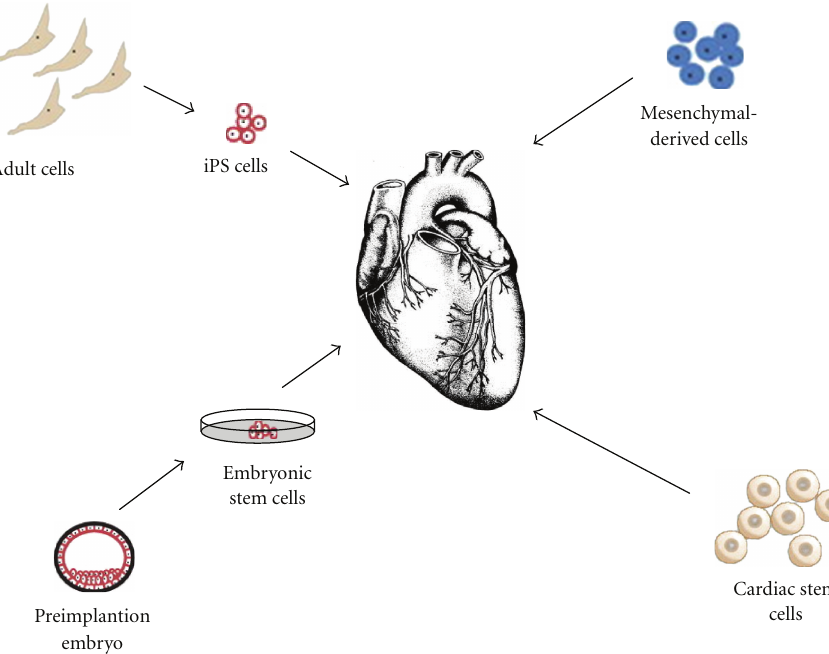
Figure 1: The cell types used in heart